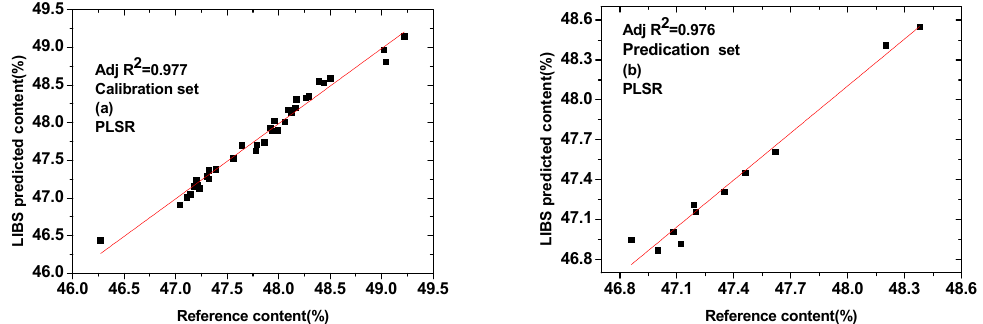
Figure 6. Comparison between LIBS predicted value (PLSR model) and reference value presented in ( a ) thirty-six calibration samples and ( b ) eleven prediction samples.